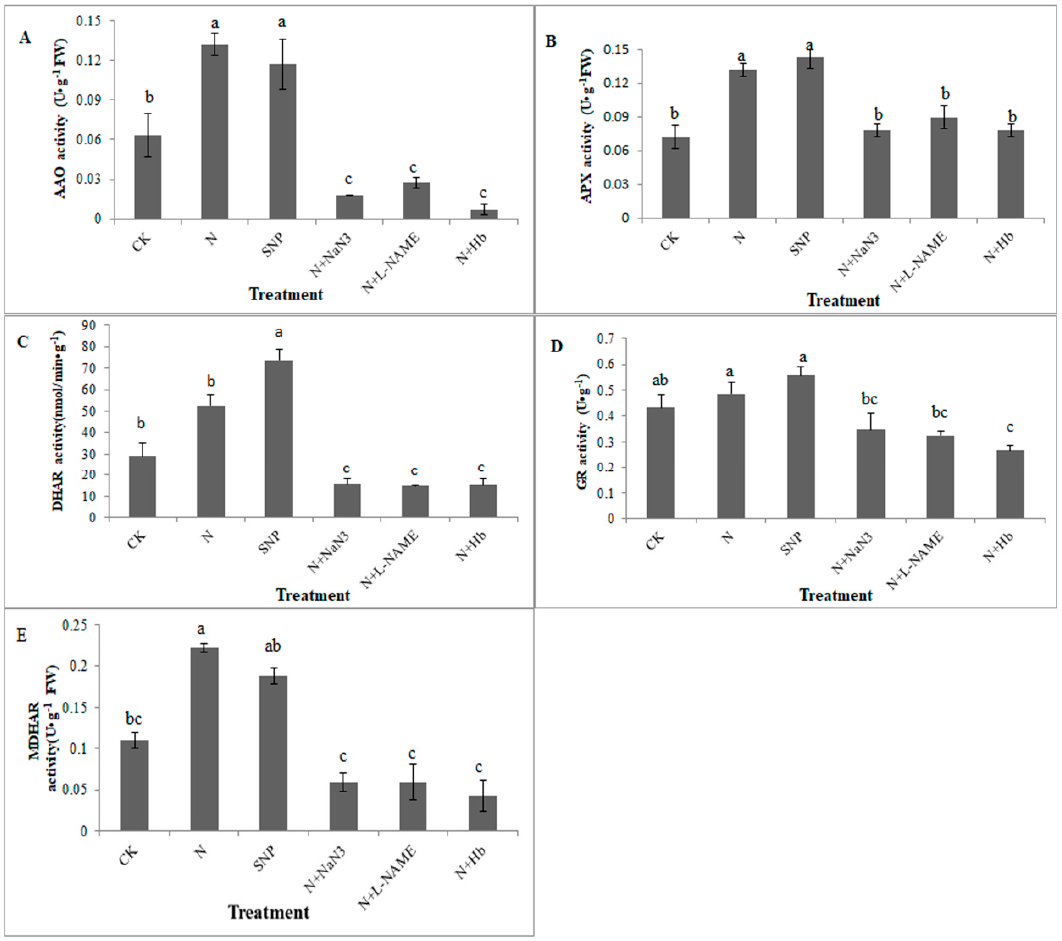
Figure 3. E ff ects of NO and NH 4 + :NO 3 − ratio on the activities of key enzymes involved in the AsA-GSH cycle in mini Chinese cabbage leaves under low light stress. The seedlings were exposed to the di ff erent treatment solutions as described in Figure 1 for 7 d. Then the activities of AAO ( A ), APX ( B ), GR ( C ), DHAR ( D ), and MDHAR ( E ) from mini Chinese cabbage leaves was analyzed. Values represent mean ± standard error (SE) of three replications for each treatment, di ff erent letters indicated significant di ff erence at p < 0.05 according to Duncan’s test.